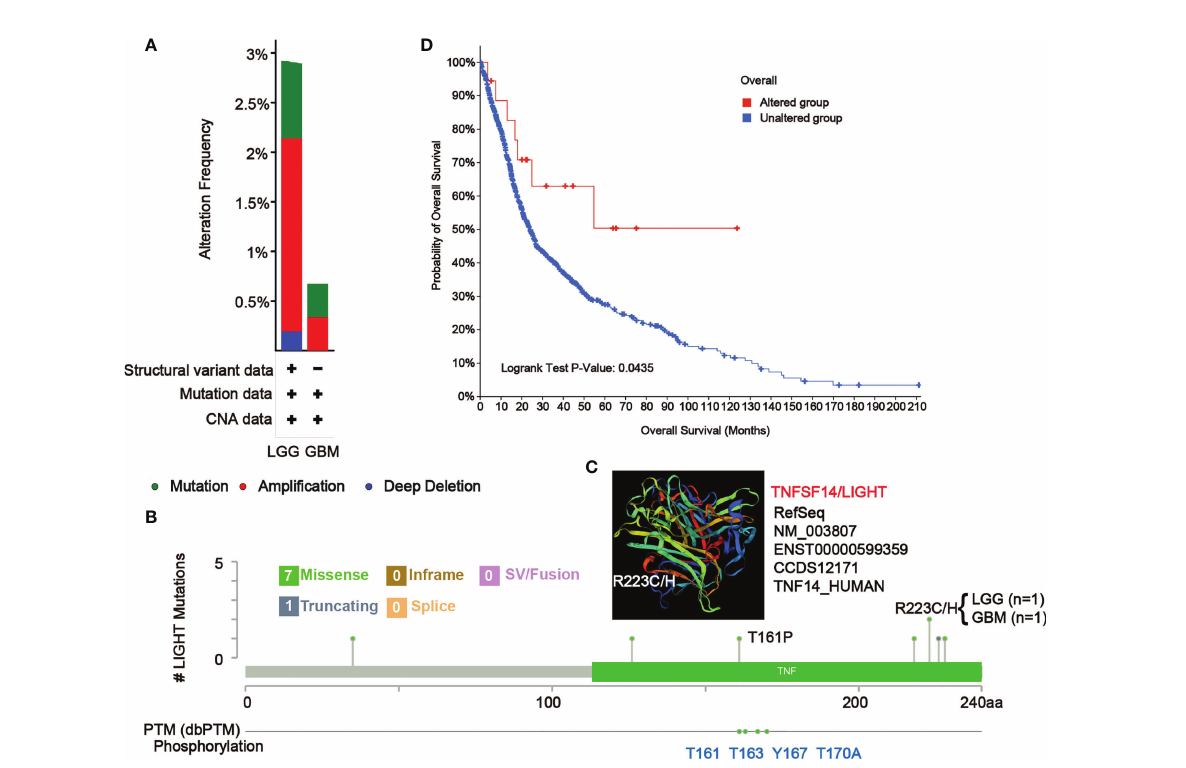
FIGURE 9 Mutation features of LIGHT in different tumors of TCGA. The alteration frequency of mutation type (A) and mutation site (B) in GBM and LGG samples are showed. We display the mutation site with the highest alteration frequency (R223C/H) in the 3D structure of LIGHT (C) . (D) We also analyzed the potential correlation between mutation status and the overall survival of GBM and LGG patients using the cBioPortal